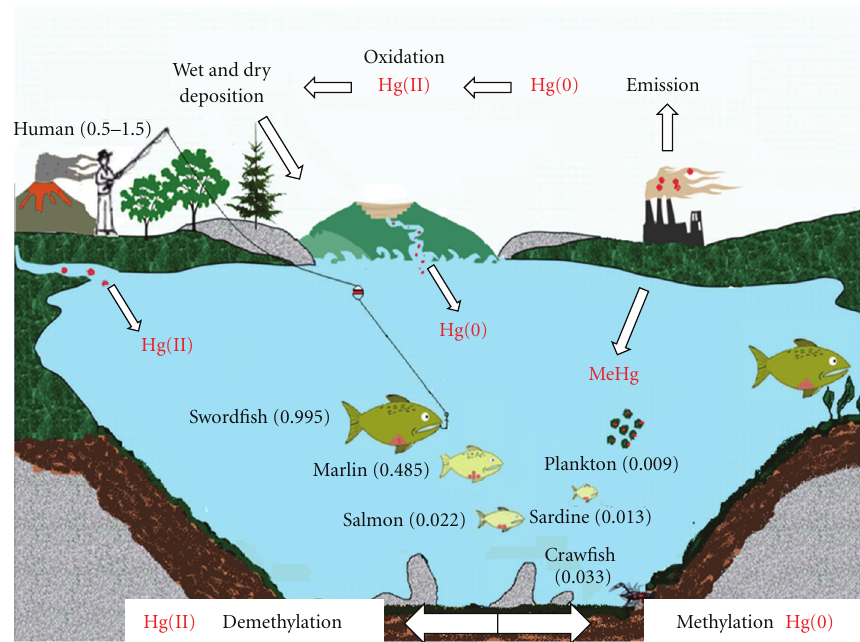
Figure 1: Cycle of mercury and its bioaccumulation in aquatic food chain. The values of mercury levels in the plankton and fish are represented as ppm. All data presented in this figure were obtained from (FDA and